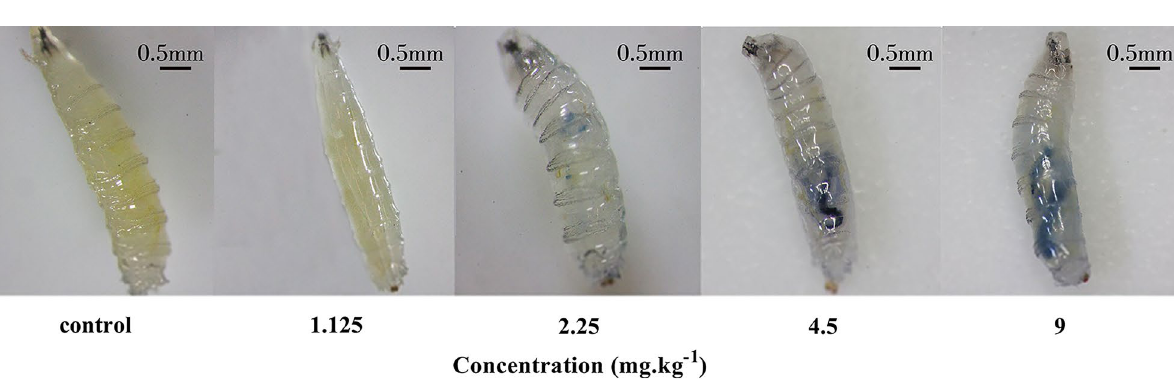
Figure 3. Cell damage in Drosophila larvae under the cadmium exposure. Representive photos of Drosophila third instar larvae with trypan blue staining. Trypan blue staining signal level indicated the damage degree of midgut